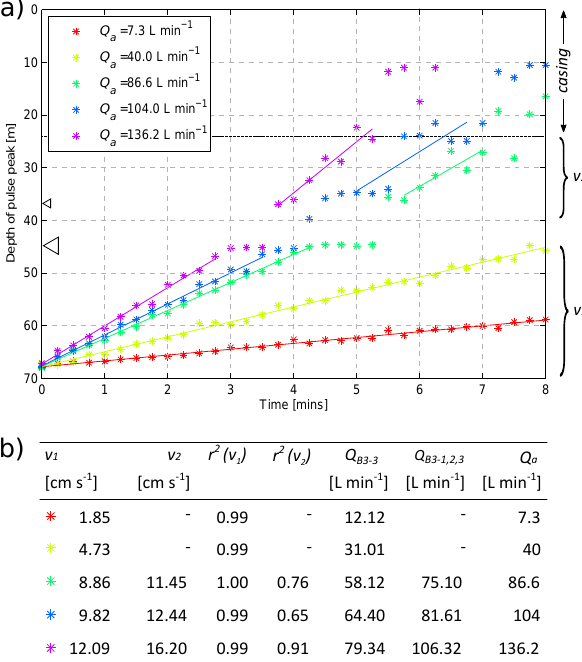
Figure 4. Temperature peak depth over time for each of the pump- ing rates, with linear least-squares regression best fit lines used to estimate the in-well vertical flow